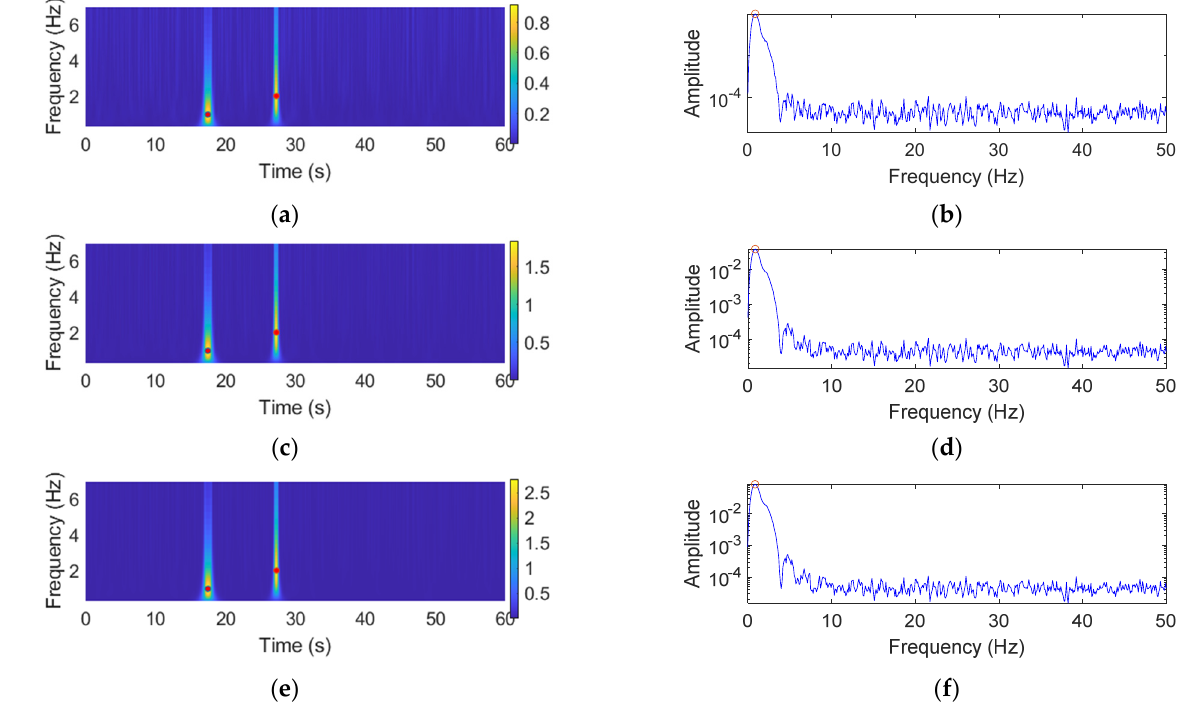
Figure 9. Signal processing results using GM-CWT and Auto PSD . The |𝑊(𝑡, 𝑠)|: ( a ) S1, ( c ) S2, and ( e ) S3. The auto PSDs: ( b ) S1, ( d ) S2, and ( f ) S3. Table 2. The results of the |𝑊(𝑡,𝑠)| and the Auto PSDs.